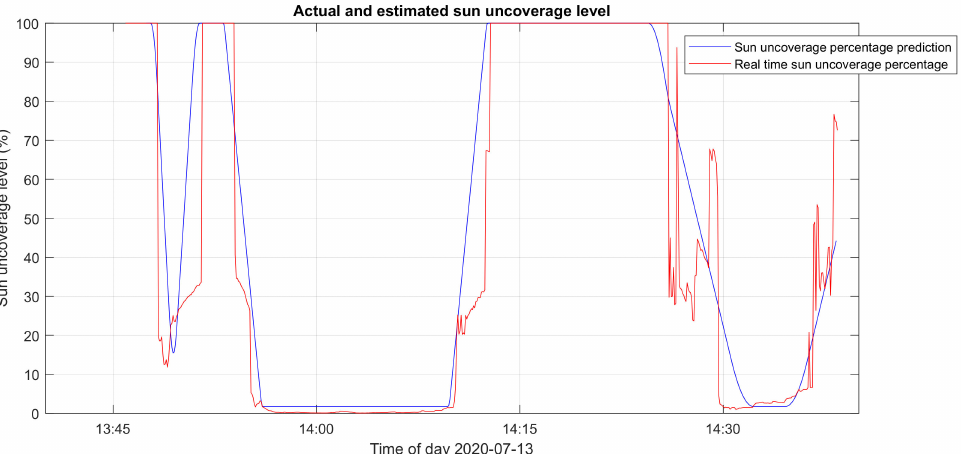
Figure 12. Comparison of the real-time sun un-coverage and the predicted level of sun un-coverage on 13 July 2020 from 13:45 to 14:40.